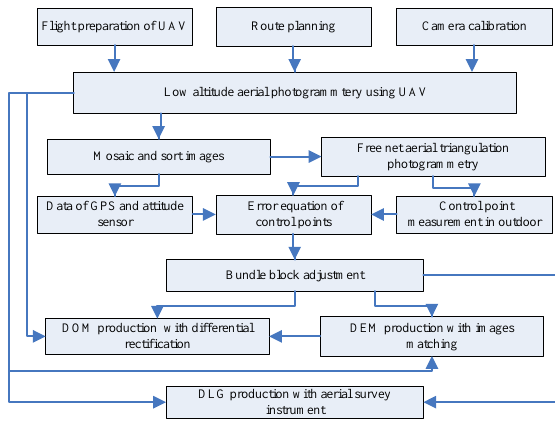
Figure 14. The flow chart about the UAVS for low altitude aerial